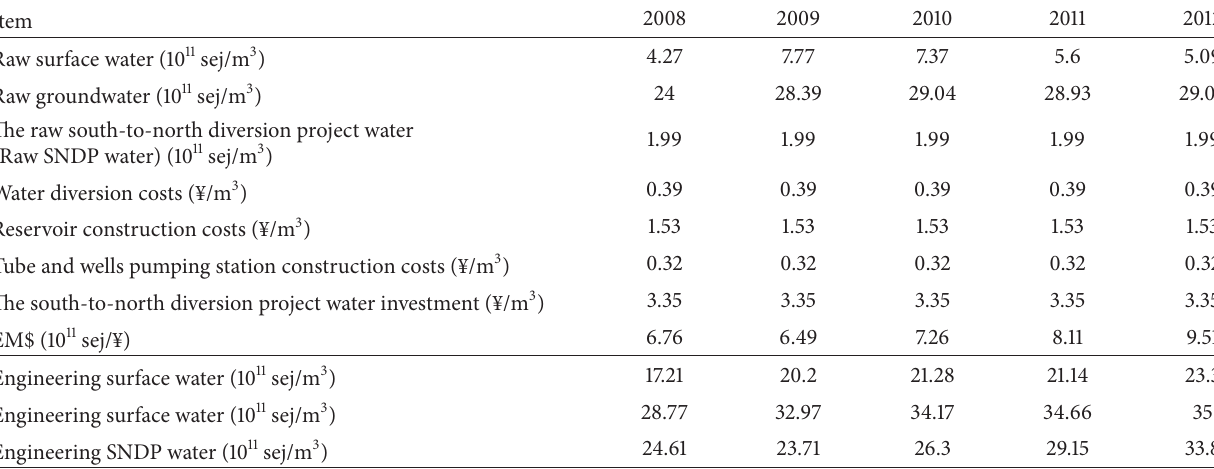
Table 2: Transformity of the engineering water of Beijing, 2008–2012.